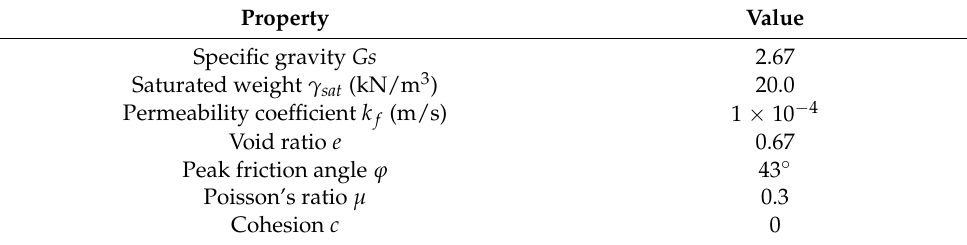
Table 2. Soil parameters adopted for the simulation of the centrifuge tests by Tran [9].